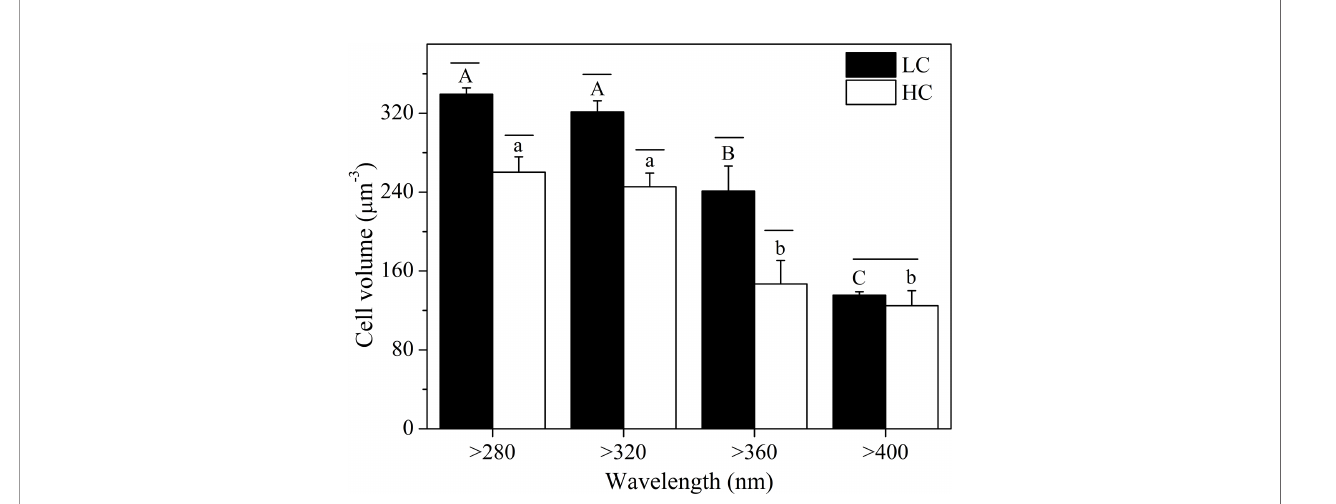
FIGURE 4 | Cell volume of S . costatum acclimated to ambient (LC, black bars) and elevated CO 2 (HC, white bars) in different spectral treatments. The different uppercase and lowercase letters represent signi fi cant differences between different spectral treatments under LC and HC conditions,